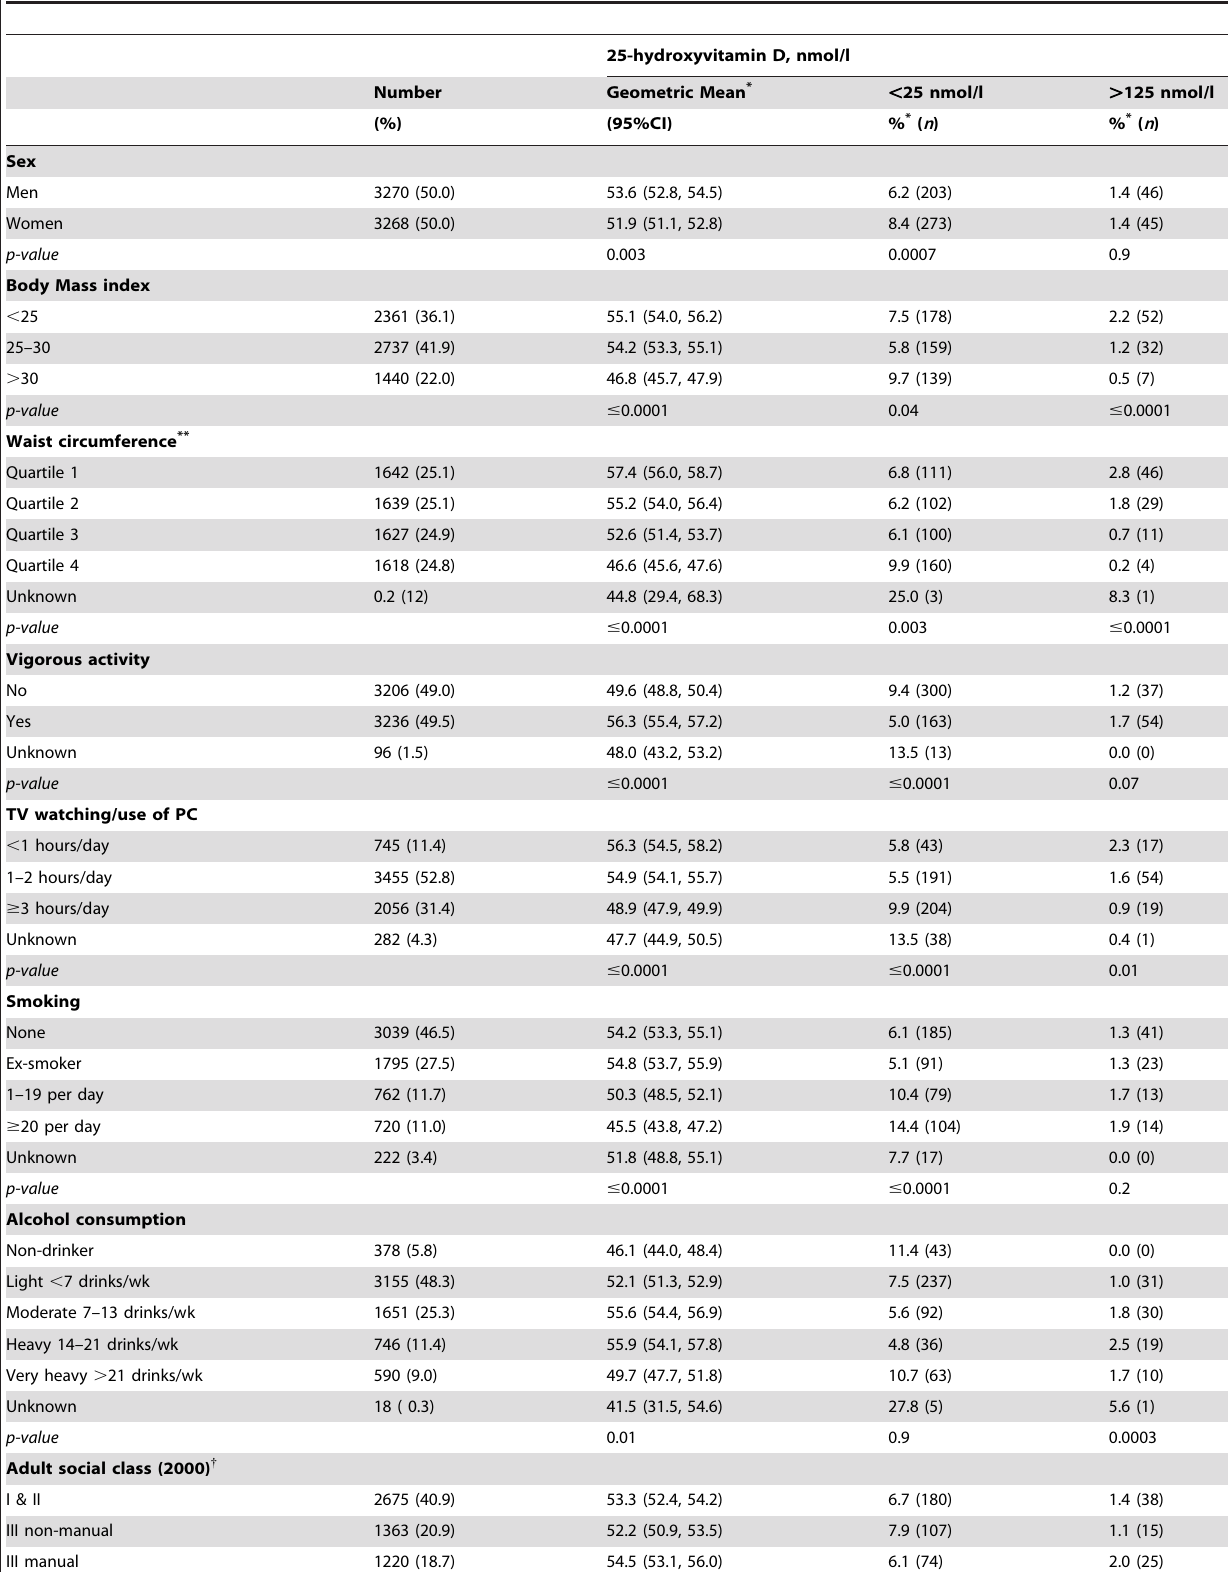
Table 1. Distribution of 25-hydroxyvitamin D concentration by background, lifestyle and social characteristics in the 1958 British birth